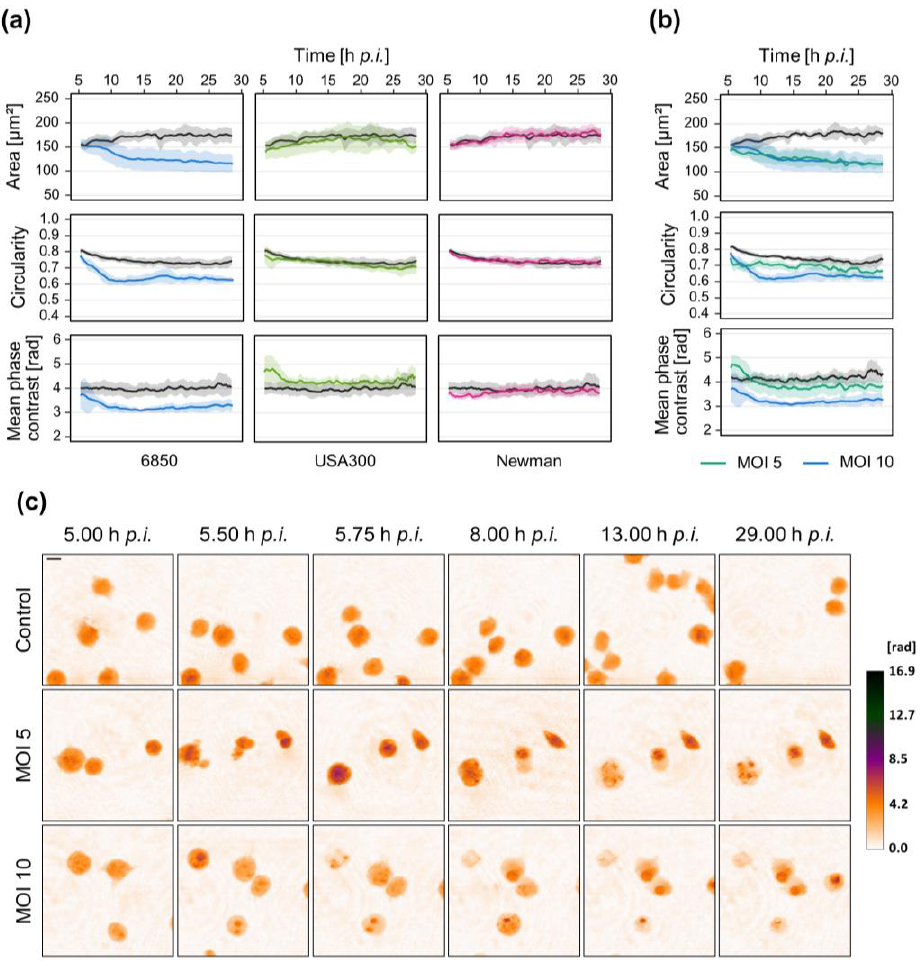
Figure 3. Morphological changes of Jurkat cells after infection with living S. aureus depend on strain and bacterial load. Jurkat cells were infected with different S. aureus strains (MOI 10; ( a )) or different bacterial loads of S. aureus strain 6850 ( b ). After 4 h, bacteria were removed by centrifugation and Lysostaphin treatment (2 µ g/mL) to prevent overgrowth. Time-lapse DHM was started at 5 h p.i. and mock-infected cells served as control. ( a , b ) DHM quantitative phase contrast images were analyzed for the average single-cell area ( µ m 2 ), average circularity (AU), and mean phase contrast (rad) per cell. Results represent mean (lines) ± SD (shading) of at least three independent experiments. Controls are depicted in black while different colors mark the individual strains ( a ) or different bacterial loads ( b ). For better visualization, curves were smoothed using moving averages with a window size of 15 measuring points. ( c ) Representative color-coded phase contrast images of Jurkat cells infected with S. aureus strain 6850 at indicated time points after infection. The scale bar corresponds to 10 µ m. The calibration bar indicates phase contrast values in